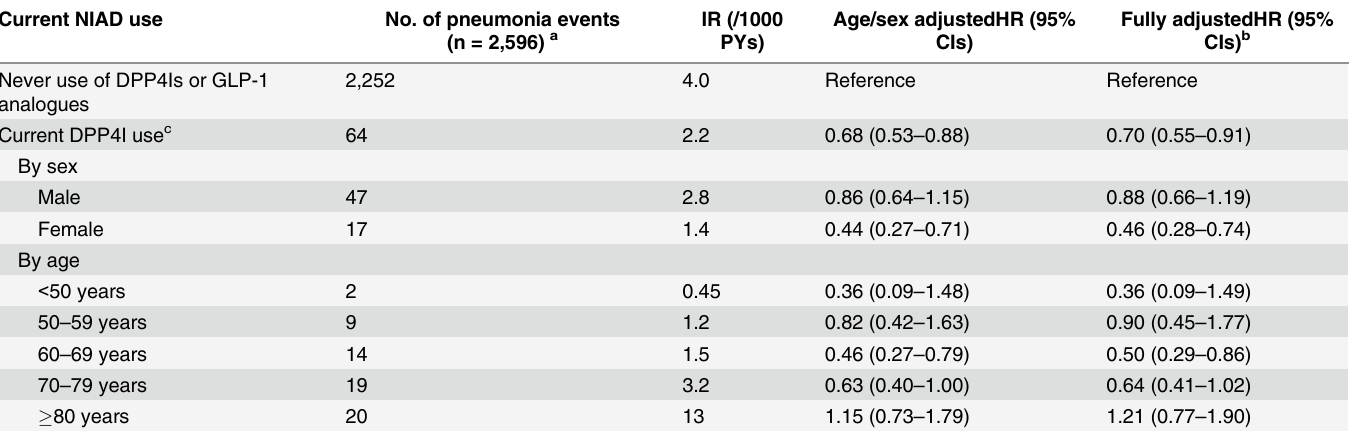
Table 3. Use of DPP-4 inhibitors and risk of pneumonia in T2DM patients, by sex and age. Current NIAD use No. of pneumonia events (n = 2,596)